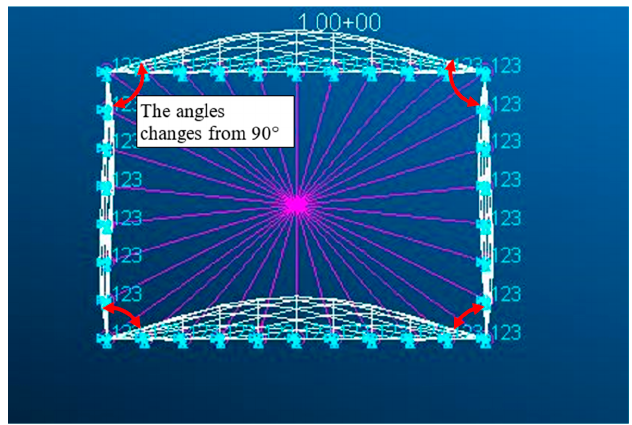
Figure 5. FE analysis for torsional buckling.